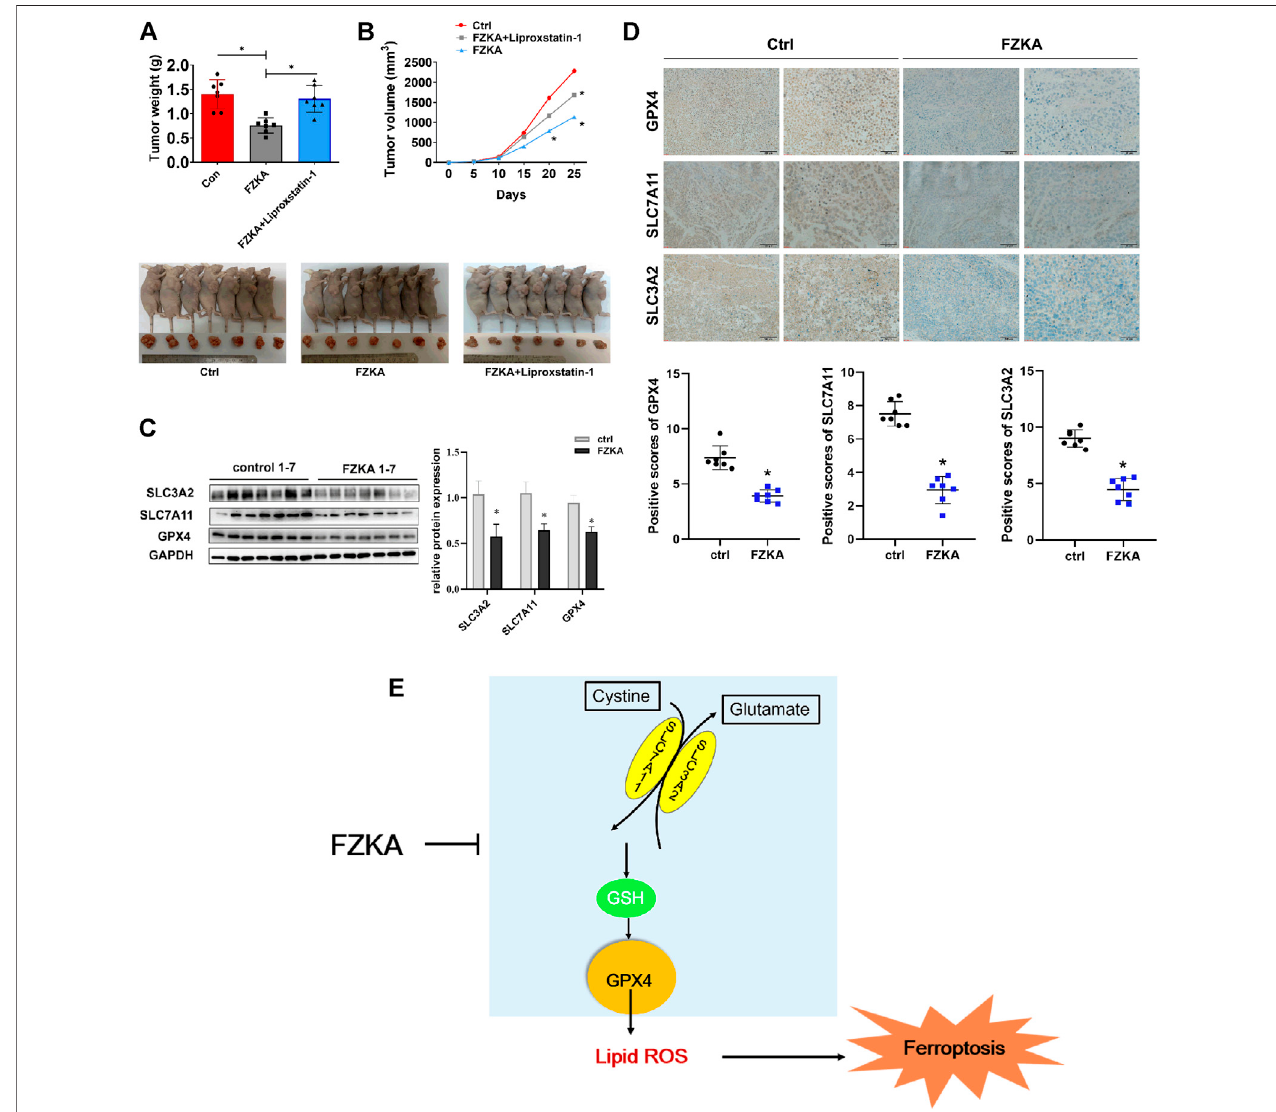
FIGURE7| ValidationofFZKA-inducedNSCLC cellferroptosis invivo . (A) ,Micetumor photographand tumor weightwasshowed.DatarepresentsMean ±SEM, n = 7. * p < 0.05. (B) , Tumor volume in each group was showed. Data represents Mean ± SEM, n = 7. * p < 0.05. (C) , Western blot analyses of GPX4, SLC7A11 and SLC3A2expressionfromtumortissues.DatarepresentsMean±SEM, n =7.* p < 0.05. (D) ,ImmunohistochemistrywascarriedouttomeasuretheexpressionofGPX4, SLC7A11 and SLC3A2 in mice tumor tissues. Data represents Mean ± SEM, n = 7. * p < 0.05. (E) , The diagram showing FZKA induced NSCLC cell ferroptosis through system xc − /GSH/GPX4 axis, and, importantly,GPX4 isthe crucial molecularin the process. Finally, inhibition ofGPX4 by FZKA leadsto NSCLC cell ferroptosis.